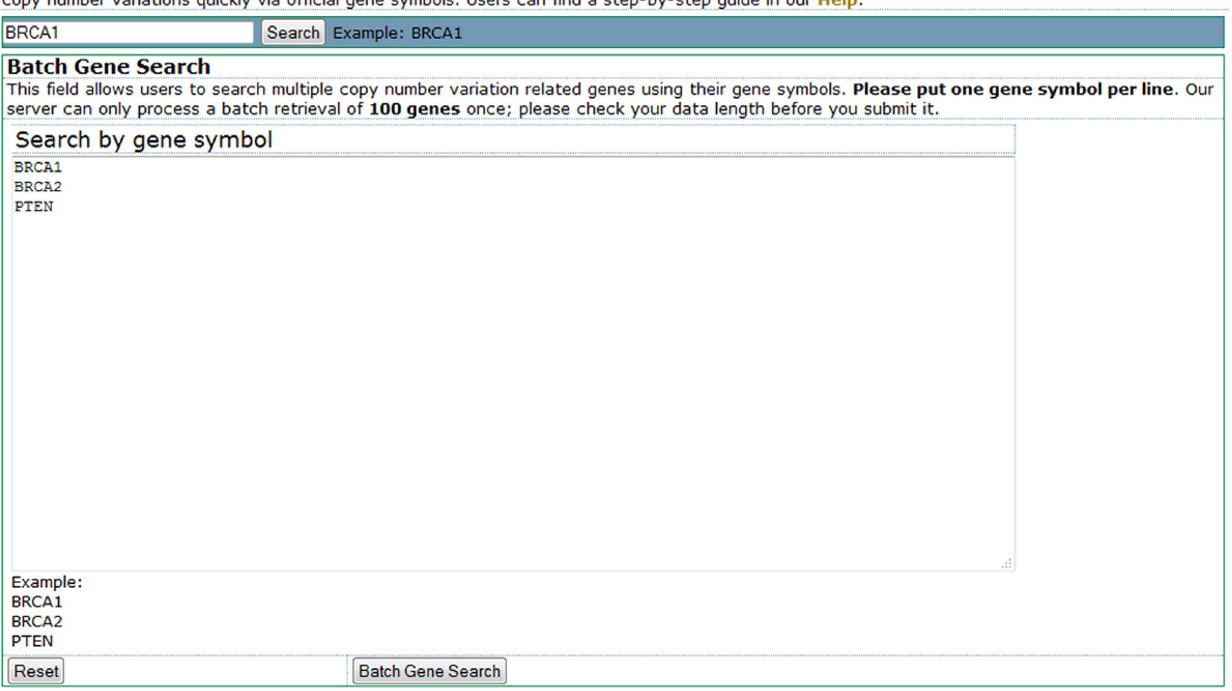
Figure 2. The layout of CNVannotator gene-based query viewer. The single gene and multiple gene query interfaces are shown. Both queries require an input of the official gene symbol(s).